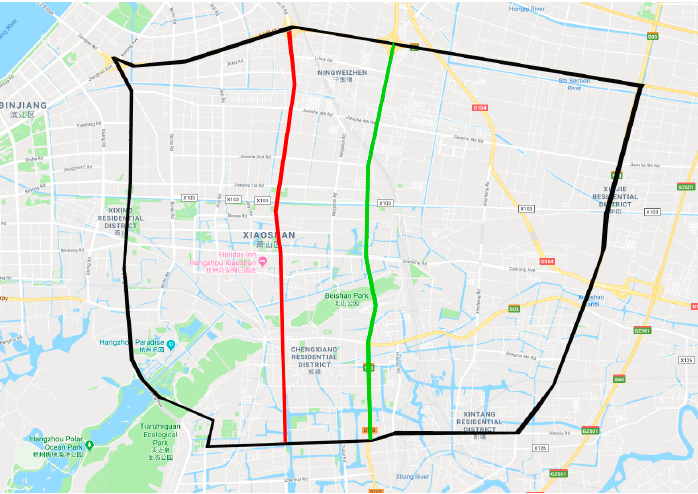
Figure 3. Traffic speed locations. Figure 3. Tra ffi c speed